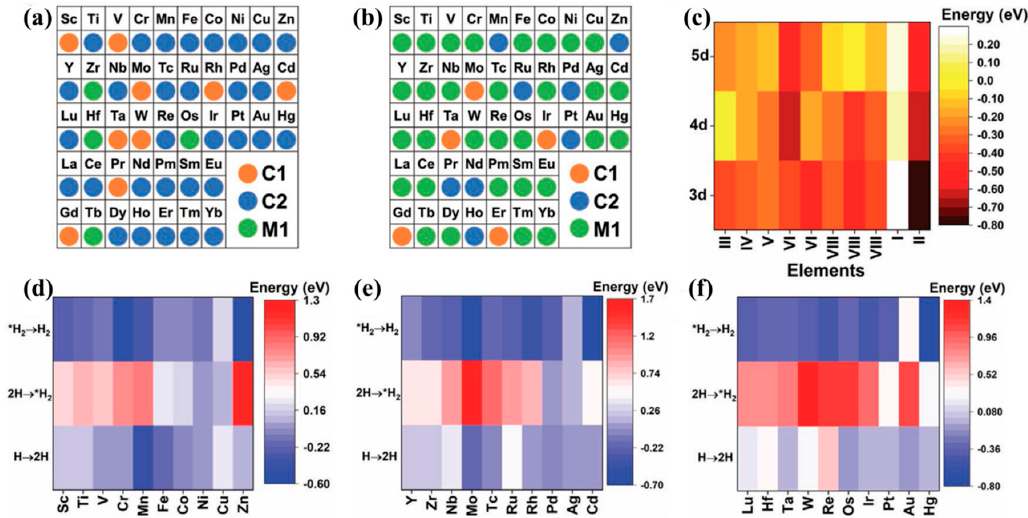
Figure 10. Density functional calculation (DFT-D) mapping of active site and reaction energy for metal-atom-anchored GDY catalysts. ( a ) Mapping of the preferable initial adsorption site for H* in hydrogen evolution reaction (HER); ( b ) mapping of the final desorption site for H 2 in HER; ( c ) mapping of the chemisorption energy for TM atom anchored GDY catalysts. Mapping of the reaction energy of HER for ( d ) 3d, ( e ) 4d and ( f ) 5d TM atom anchored GDY catalysts (reproduced with permission from [119] . Copyright Wiley-VCH, 2020).